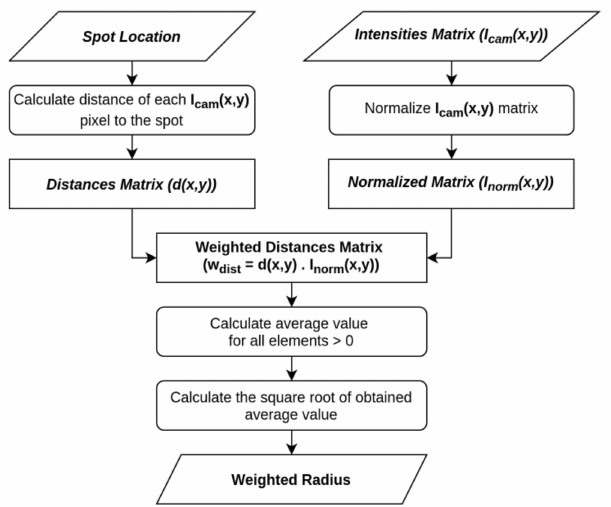
Figure 5. Weighted Radius diagram that takes both the spot location in the camera, as pixel coordi- nates, and the captured intensities as inputs. For the calculation of the value of the weighted radius, the normalized captured intensities and distances of each pixel of the camera to the spot are required. The distances matrix is of the same size of the captured intensities, where similarly to the case of the weighted average, each value will correspond to the distance of that pixel to the spot’s location in the image. Next, the normalized intensities matrix is obtained by dividing each pixel’s intensity value by the maximum pixel intensity read. Then, the weighted radius can be calculated by obtaining the square root of the selective average (discarding null values) of the Hadamard product between the distances matrix and normalized intensity